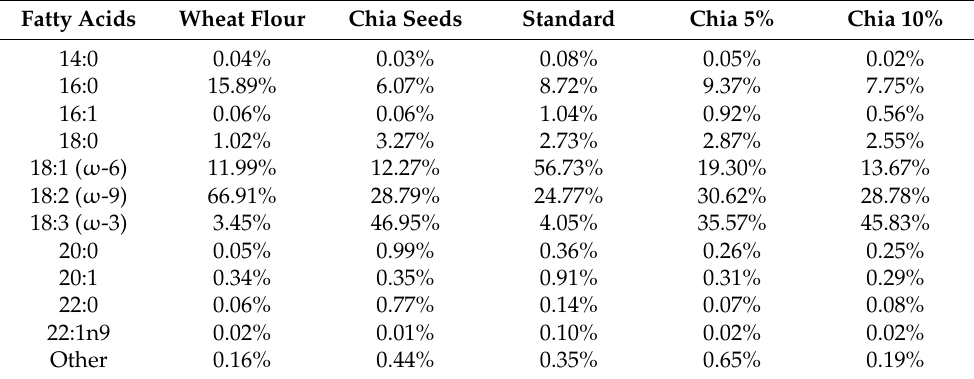
Table 7. Fatty acid content in the bread with 5 and 10% of chia share. Fatty Acids Wheat Flour Chia Seeds Standard Chia